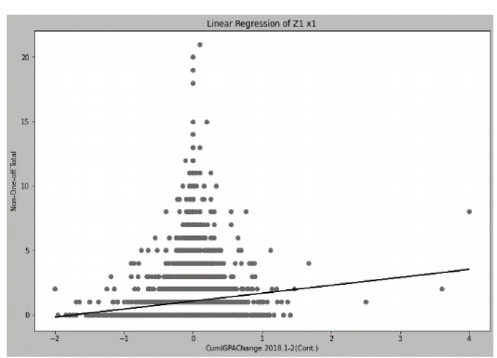
Figure 1. Linear Regression of Z1 x1 in Finding 1